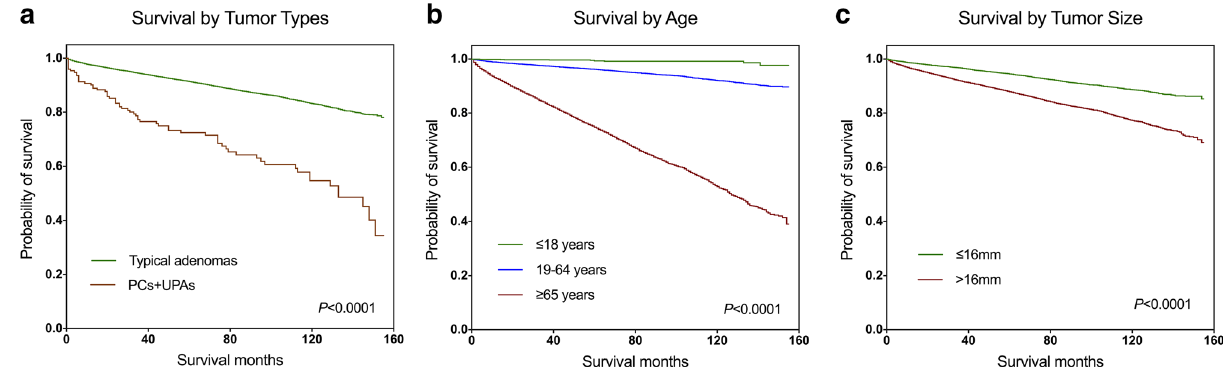
Figure 2. Kaplan–Meier survival curves of all primary pituitary tumors stratified by ( a ) subtypes, ( b ) age groups and ( c ) tumor size. UPAs Uncertain behavior pituitary adenomas, PCs Pituitary carcinomas.